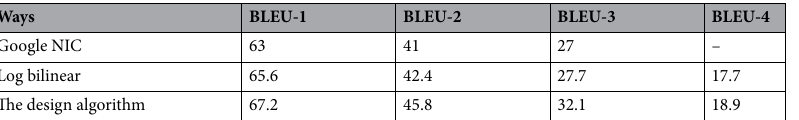
Table 5. The results of the experiments on the database Flickr8K. Methods are divided into Google NIC, Log Bilinear and The design algorithm.